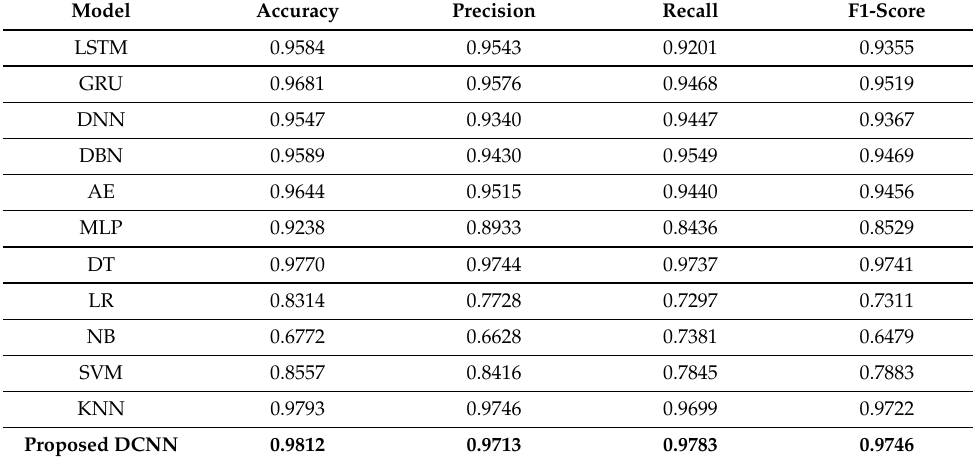
Table 9. A comparison of DCNN with other DL models on multi-class category.